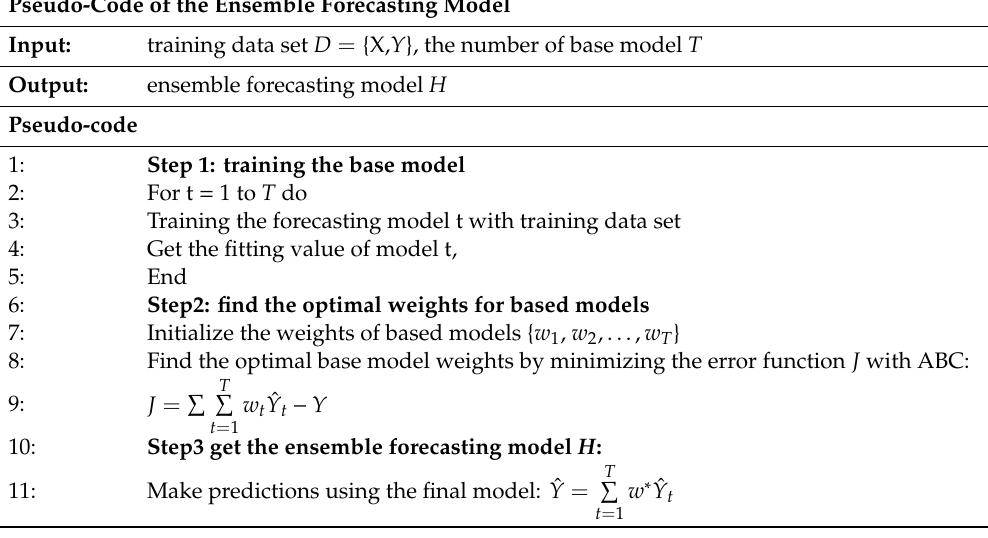
Table A4. Pseudo-code of the ensemble forecasting model. Pseudo-Code of the Artificial Bee Colony